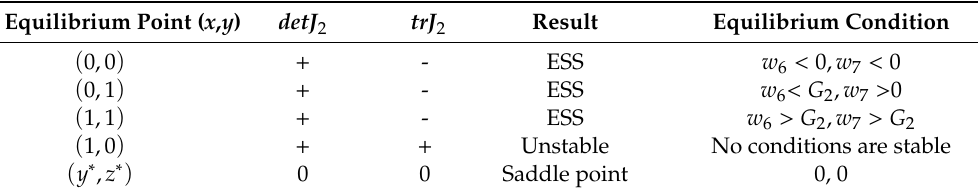
Table 4. Stability between LEPD and